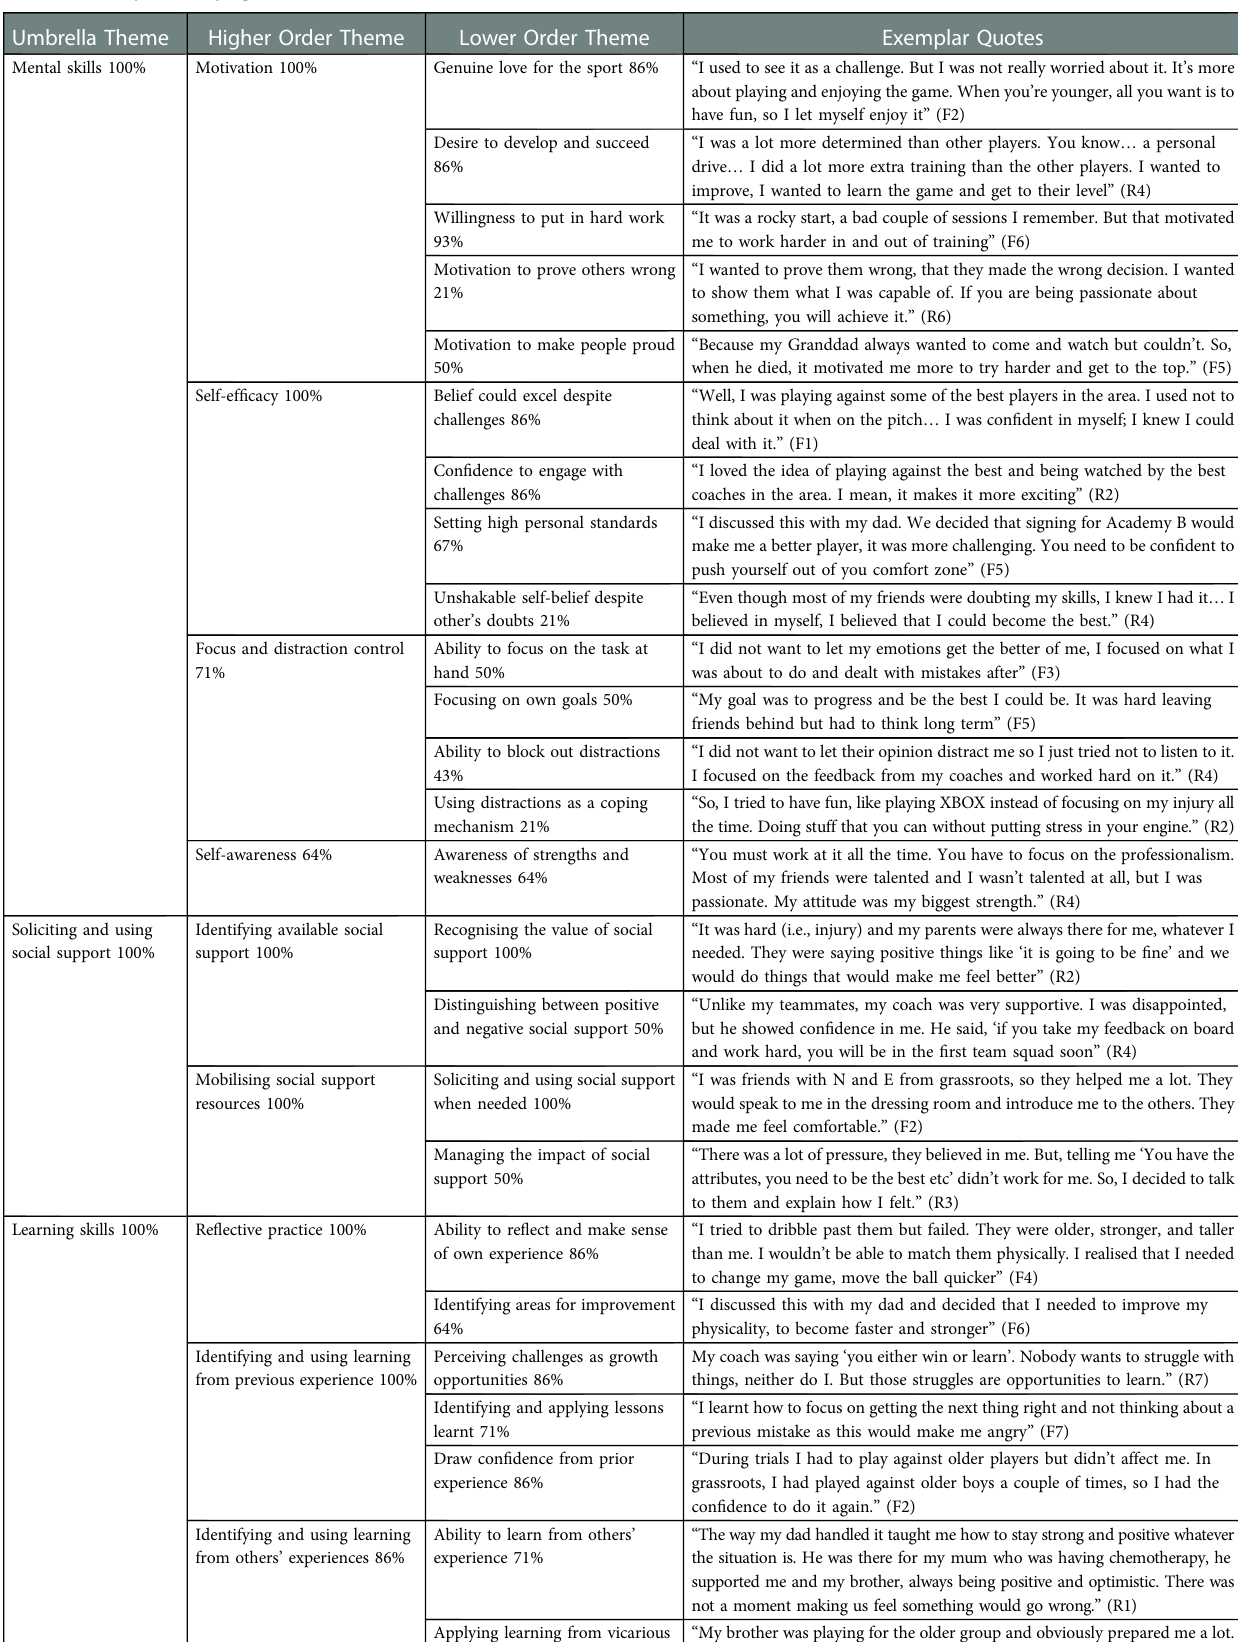
TABLE 2 Self-reported coping skills